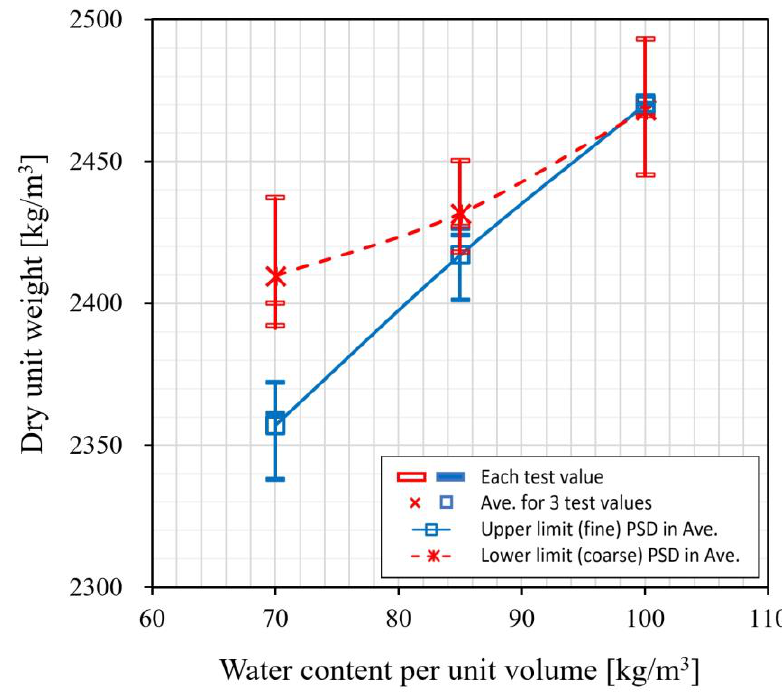
( c ) Figure 5. Input seismic waves used in FE analysis. ( a ) Hachinohe wave; ( b ) Ofunato wave; ( c ) artificial wave. Lastly, from the numerical analysis results, the seismic stability of the hardfill dam body was evaluated by comparing the maximum stress generated inside the hardfill dam body with the “ required hardfill strength ” as applied with a safety factor of 1.5 under the seismic load condition [3].